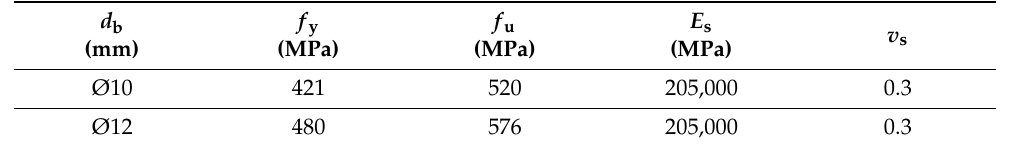
Figure 1. Section layout details of typical RC girders with dapped ends in the previous experimental investigation [39].